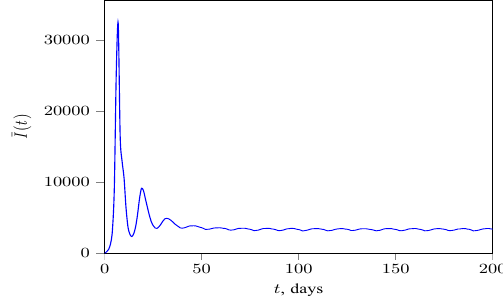
1 Figure 9. Dynamics of point estimates I ( t ) at experiment